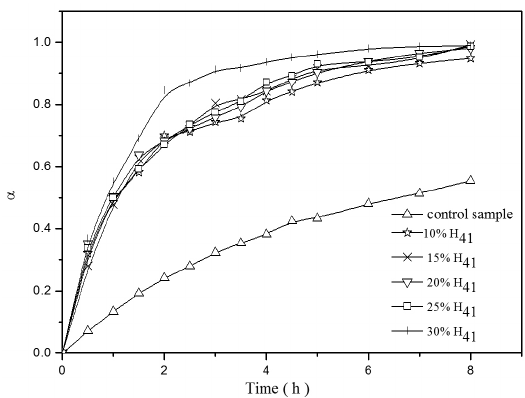
Figure 3. Conversion-time curves for the control sample and H-IPNs with different content of H